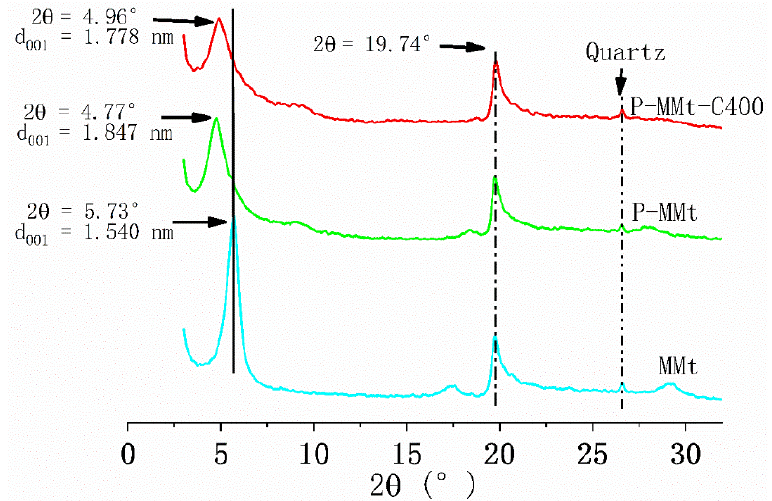
Figure 1. The XRD patterns of MMt, P-MMt, and P-MMt-C400.